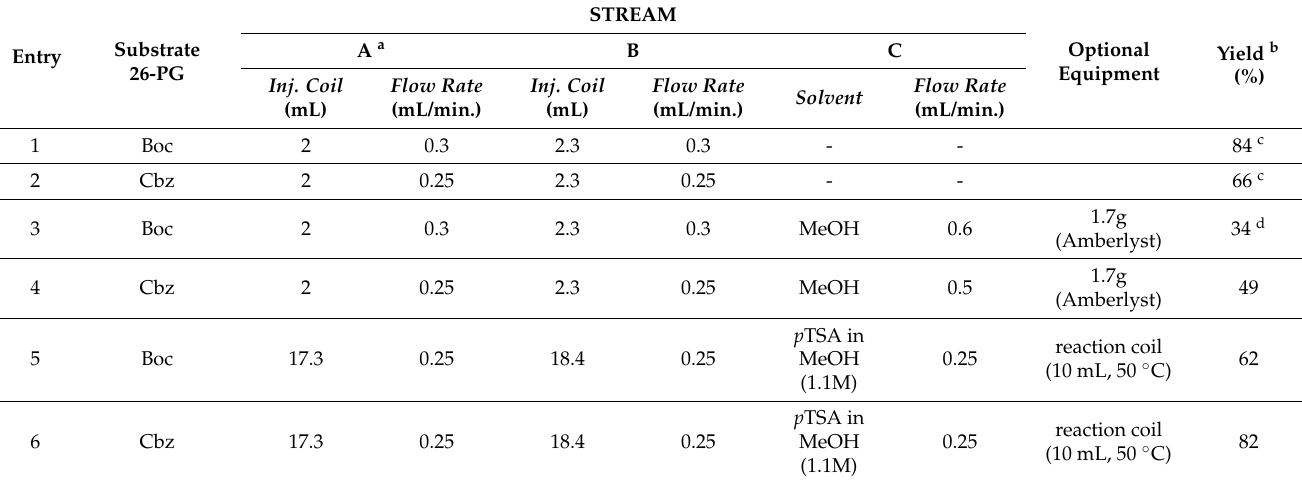
Table 2. Optimisation of the flow addition/deprotection reaction sequence.